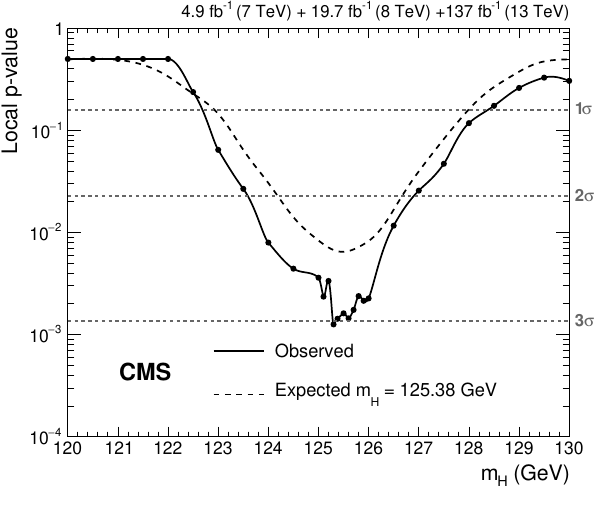
Figure 13 . Observed (solid black) and expected (dashed black) local p -values as a function of m , H √ extracted from the combined fit performed on data recorded at s = 7 , 8, and 13 TeV, are shown. The expected p -values are calculated using the background expectation obtained from the S+B fit and injecting a signal with m = 125 . 38 GeV and µ = 1 H